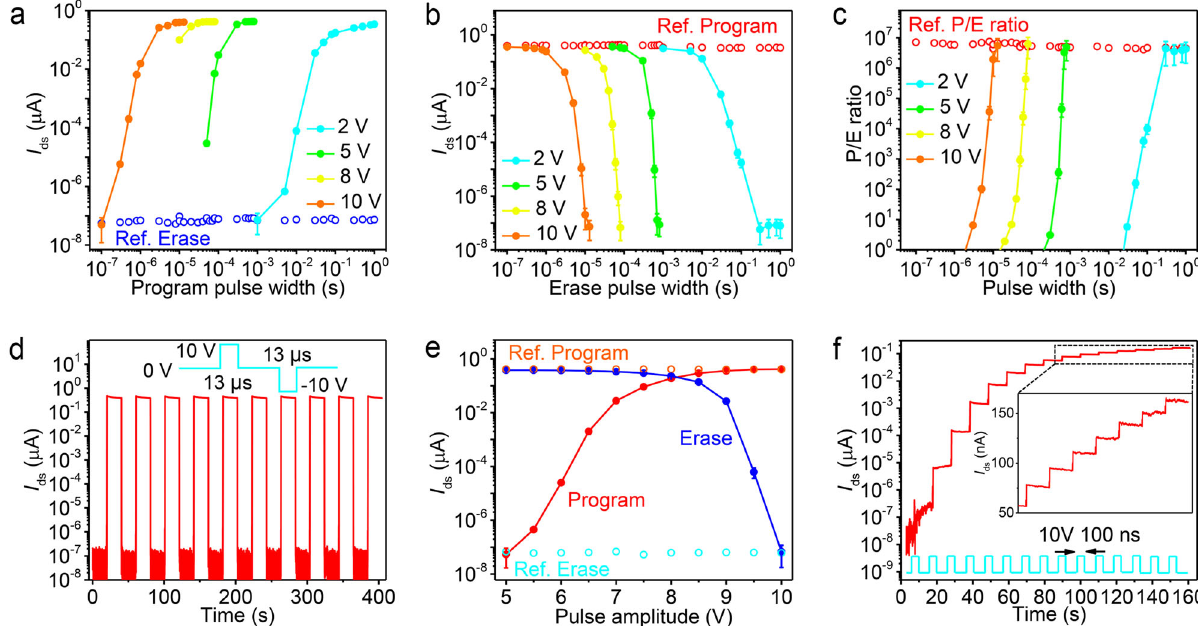
Fig. 4 Programing/erasing speed measurements. a , b , c Program a and erase b state current and the P/E current ratio c of a vdW FeFET as a function of V I V = 0.5 V after applying each pulse. The reference erase (Ref. Erase) and program (Ref. tg pulse width for various pulse amplitudes. ds was probed at ds Program) currents were collected after each reset operation but before the writing operation. The device has a six-layer MoS 2 channel and a 36-nm-thick CIPS layer. d Dynamic characteristic of the same device in response to periodic V tg pulses with the amplitude of 10 V and width of 13 μ s. I ds was probed at V = 0.5 V. e I fi xed at 13 μ s. f I – time curve of the ds ds as a function of the program (red dot) and erase (blue dot) pulse amplitude. The pulse width was ds same vdW FeFET under a 10 V/100 ns pulse train. Dots and bars in a , b , c , and e are the mean and standard deviation of I ds recorded in 20 s after applying each pulse, Fig. 12 – 18. Before each program or erase pulse, vdW FeFET was set into the erased or programed state through a reset pulse. As shown in Fig. 4a, when the FeFET is switched from the erase to program state with a 2 V gate voltage pulse, I ds increases gradually at fi rst, and then rapidly with increasing pulse width and fi nally saturates at around 80 ms. Conversely, I ds decreases with increasing erase pulse width when the vdW FeFET is switched from the program to erase state, as shown in Fig. 4b. Stable